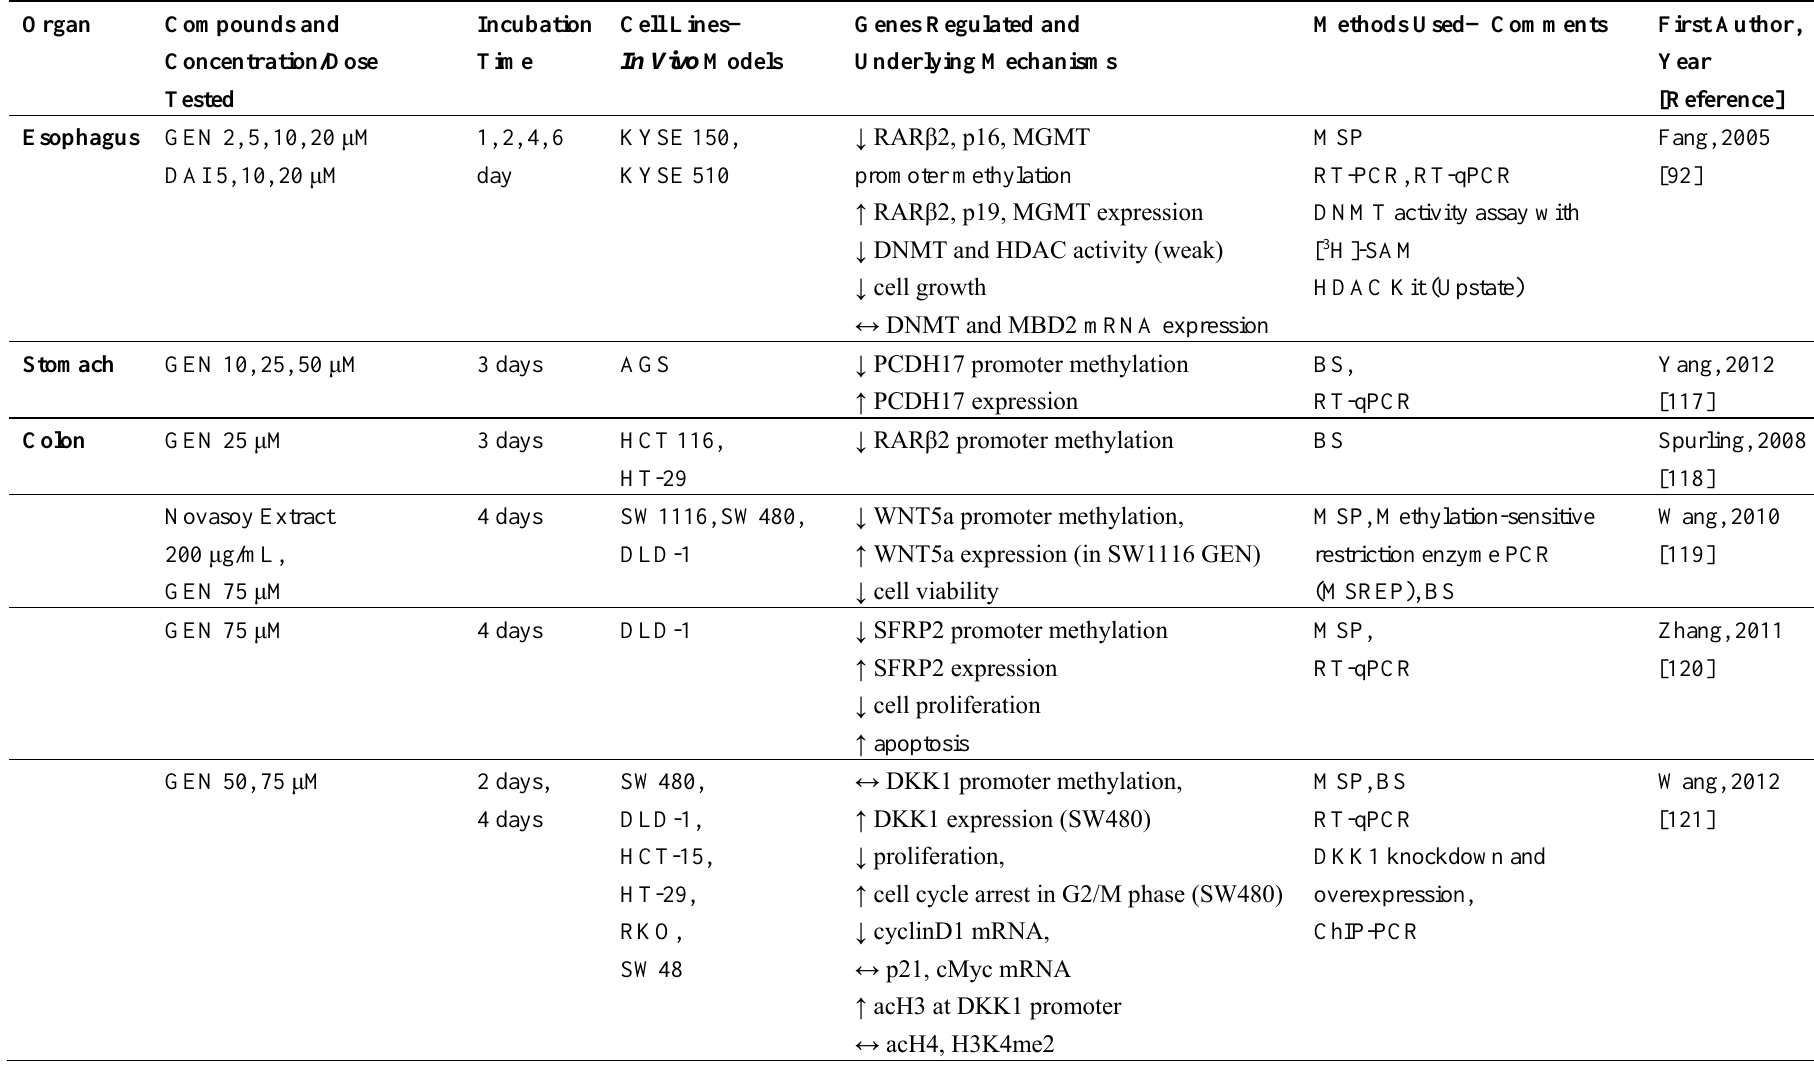
Table 4. Soy isoflavones targeting epigenetic mechanisms in the gastrointestinal tract (GIT) in vitro and in vivo . Organ